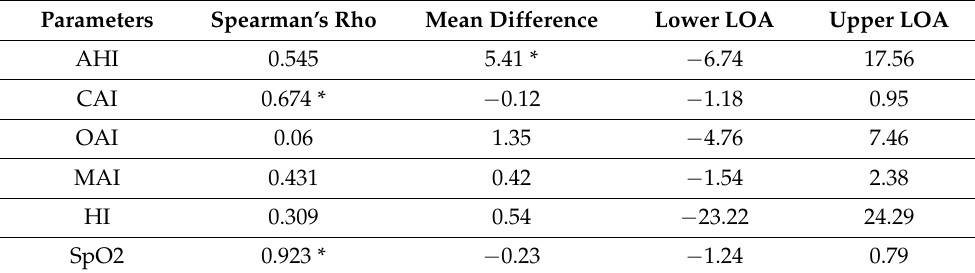
Table 2. Comparison of Respiratory Index between Alice PDX (PSG) and Alice NightOne